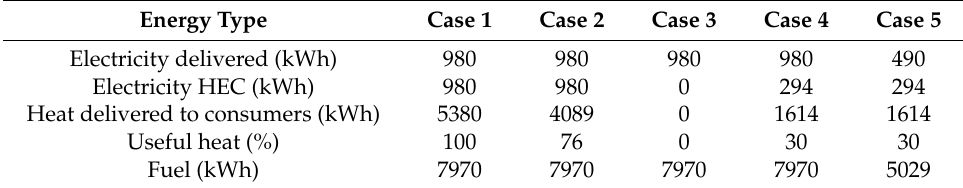
Table 2. The main characteristics of the analyzed cases (average hourly